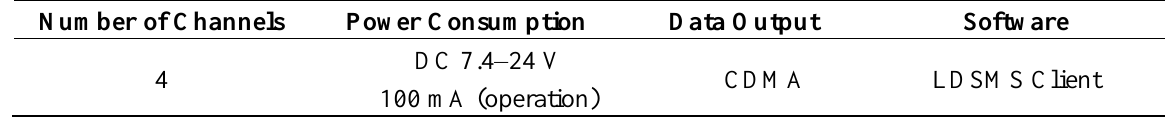
Table 2. Sensor node specification.